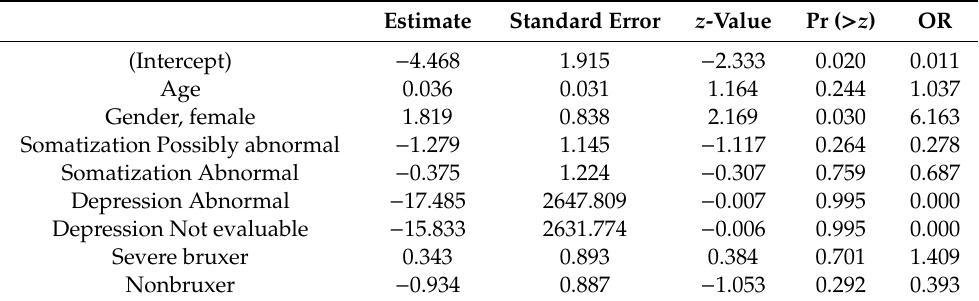
Table 5. Multivariate logistic regression model with RDC / TMD group II (disc displacements) as the dependent variable. Estimates of the model coe ffi